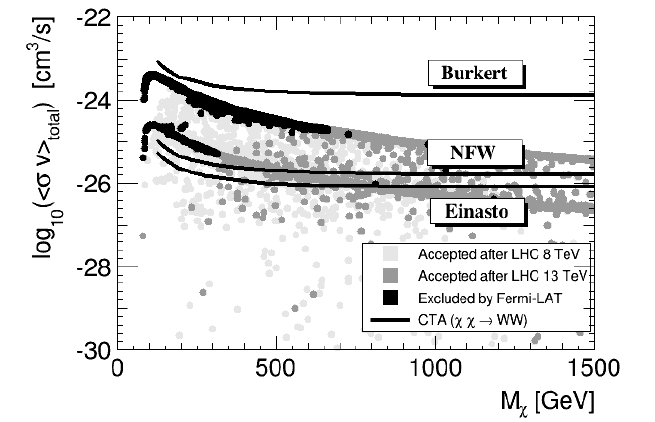
Figure 26 . Total annihilation cross section as a function of the neutralino 1 mass. The CTA prospective upper limits are superimposed for the Einasto, NFW and Burkert